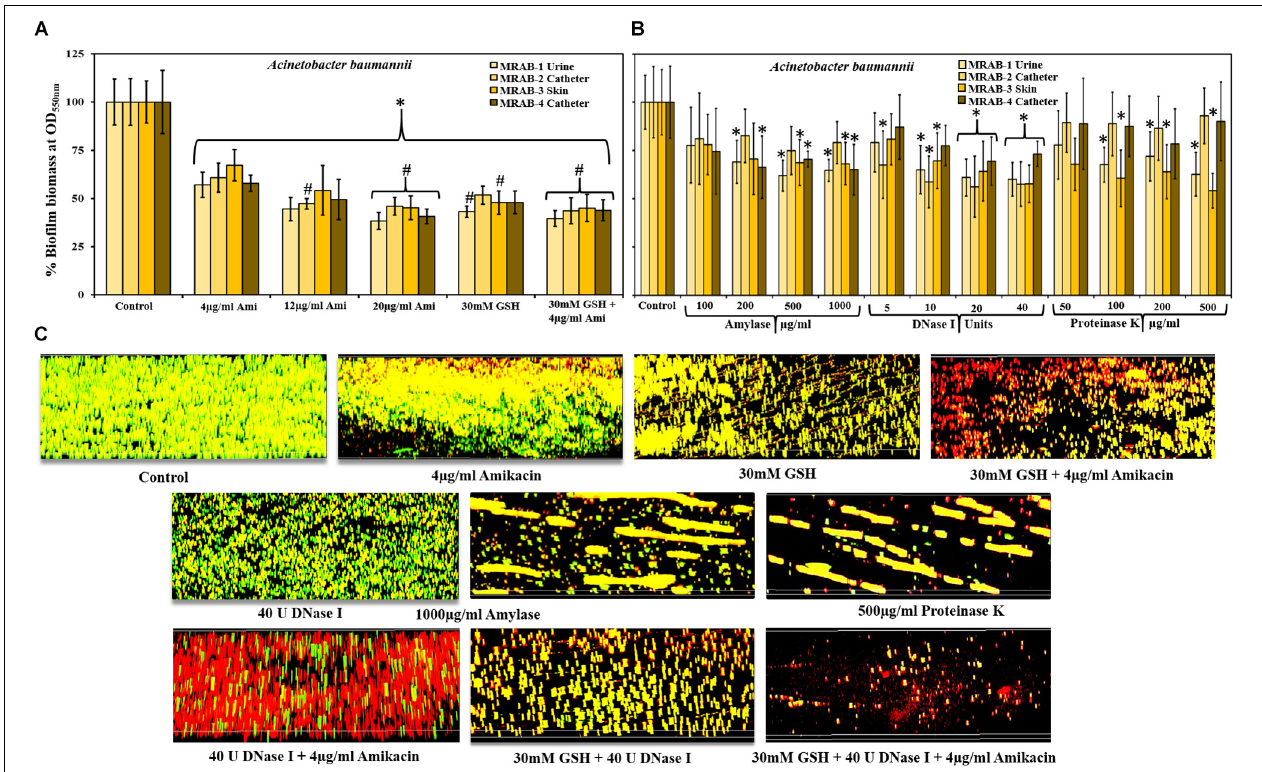
FIGURE 3 | Effect of GSH, antibiotics and enzymes on MRAB biofilm biomass and biofilm architecture. (A) Biofilm biomass of MRAB isolates measured using the crystal violet assay showed statistically significant decreases in biomass when treated with amikacin, GSH alone or in combination, compared to untreated control. Amikacin at 1 × MIC reduced biomass to 58–67% whereas at 5 × MIC, biomass was reduced to between 38 and 46% for all isolates. 30 mM GSH decreased biomass to 43–52%, while a combination of GSH + amikacin decreased biomass by 40–45% for all isolates. (B) Both 20 and 40U DNase-I significantly reduced biofilm biomass (56–73% for all MRAB isolates). At higher concentrations of amylase (500 and 1000 µ g/ml) and Proteinase K (200 and 500 µ g/ml) treatment reduced biofilm biomass by 61–79% and 54–93%, respectively. (C) Biofilm architecture of MRAB-3 imaged using CLSM and complemented with Live/dead bacterial viability stain, showed a marked and distinct type of disruption in biofilm architecture when treated singly with amikacin, GSH, or enzyme, or combinations thereof. In panels (A,B) ∗ P < 0.05 when compared to control and # P < 0.05 when compared to 4 µ g/ml amikacin. Data represent the mean ± SD of n = 4 experiments performed in biological